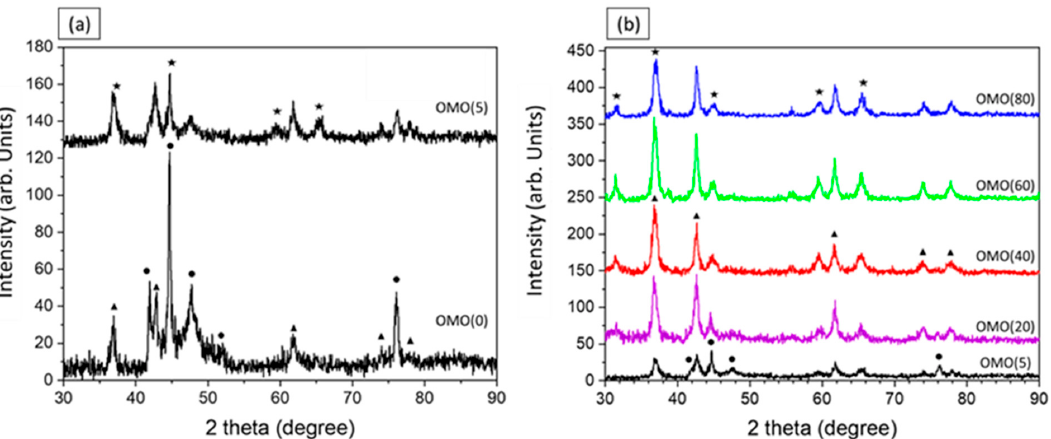
Figure 1. XRD patterns of the OMO-series ( a ) OMO(0) and OMO(5) and ( b ) in various oxidation times; the symbols next to different reflections indicate their assigned phase: ( • ) Co (00-001-1254 PDF card No.), ( ▲ ) CoO (00-043-1004 PDF card No.), and ( ★ ) Co 3 O 4 (01-080-1533 PDF card No.).